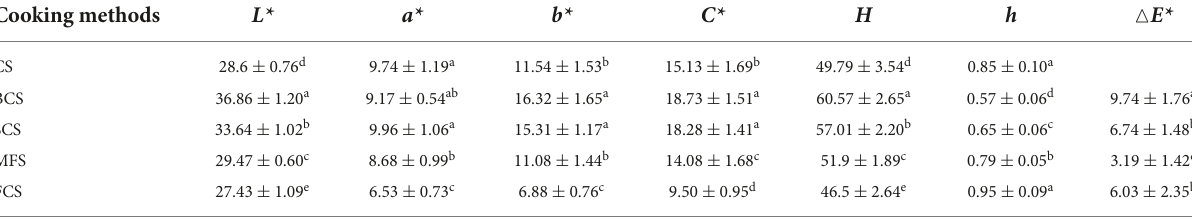
TABLE 3 Effects of different cooking methods on color in C. squamulosa.